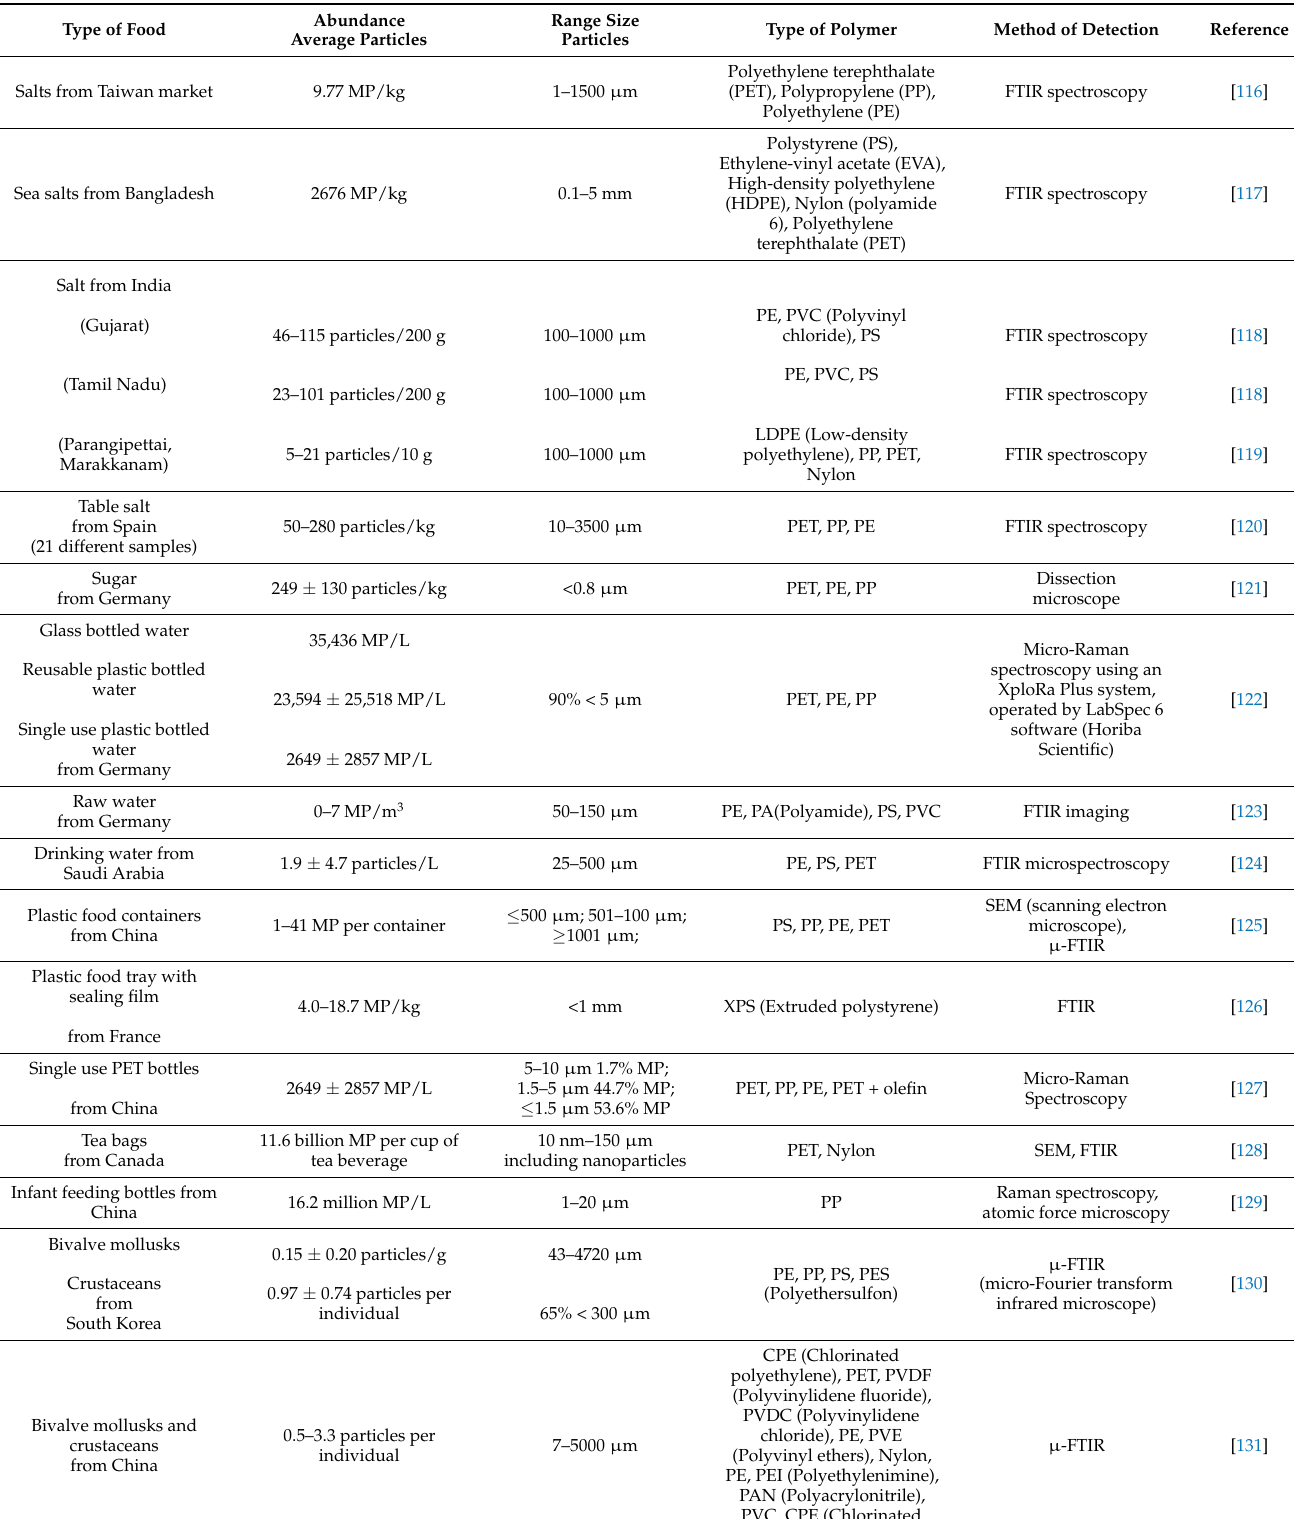
Table 1. Presence of microplastics in different food